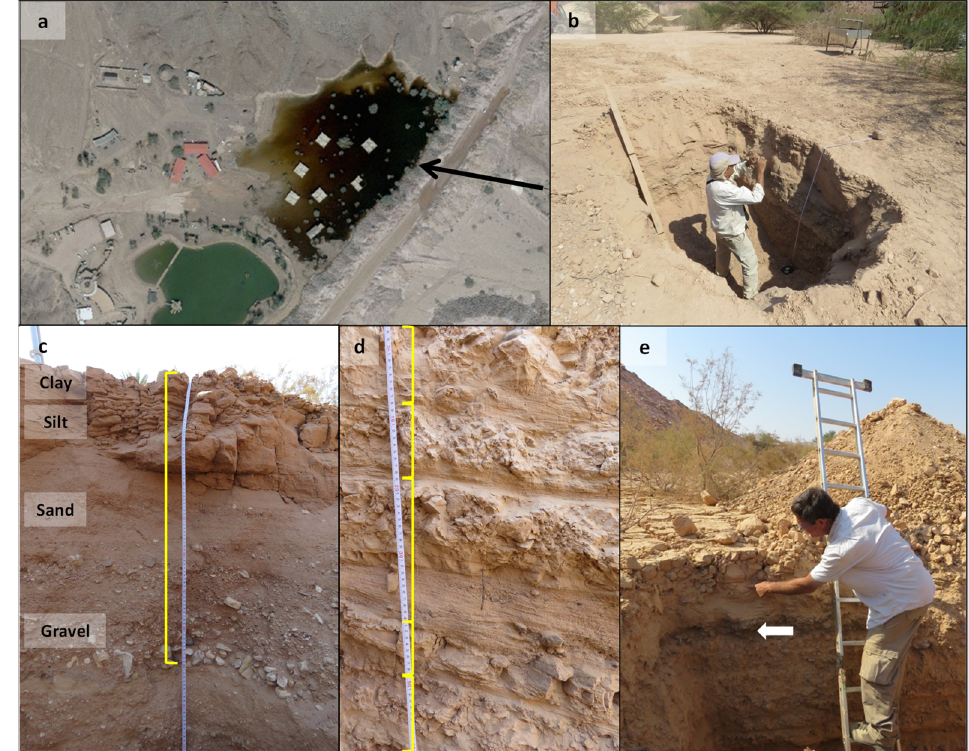
Figure 2. Stratigraphic sections in the Nehushtan Reservoir. ( a ) The sediment-laden water in the Nehushtan Reservoir following the Oct. 2015 heavy flash flood event. ( b ) Stratigraphic documentation of pit 15. ( c ) Thick (89 cm) sedimentary layer deposited by the Oct. 2015 flood event; pit 15. The event layers consist of gravel, sand and silt overlain by a relatively thin layer of clay. ( d ) Sequence of five flood event couplets near the dam, part of the chronological sequence determined using stratigraphic sections. ( e ) The Oct. 2015 event layer (pit 3) was deposited above the artificial fill (white arrow) placed as part of local efforts to improve infrastructure.